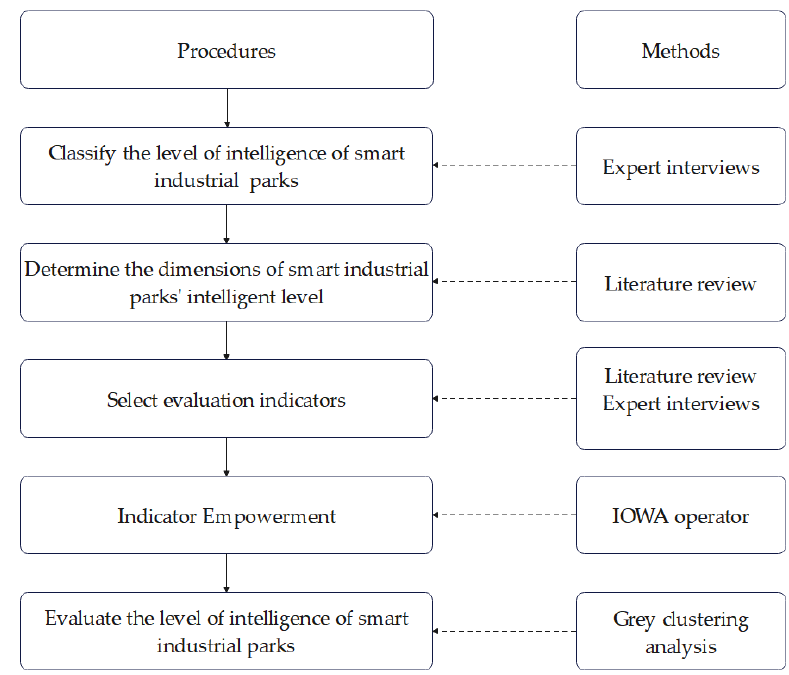
Figure 1. Five procedures for assessing the intelligence level of SIPs.